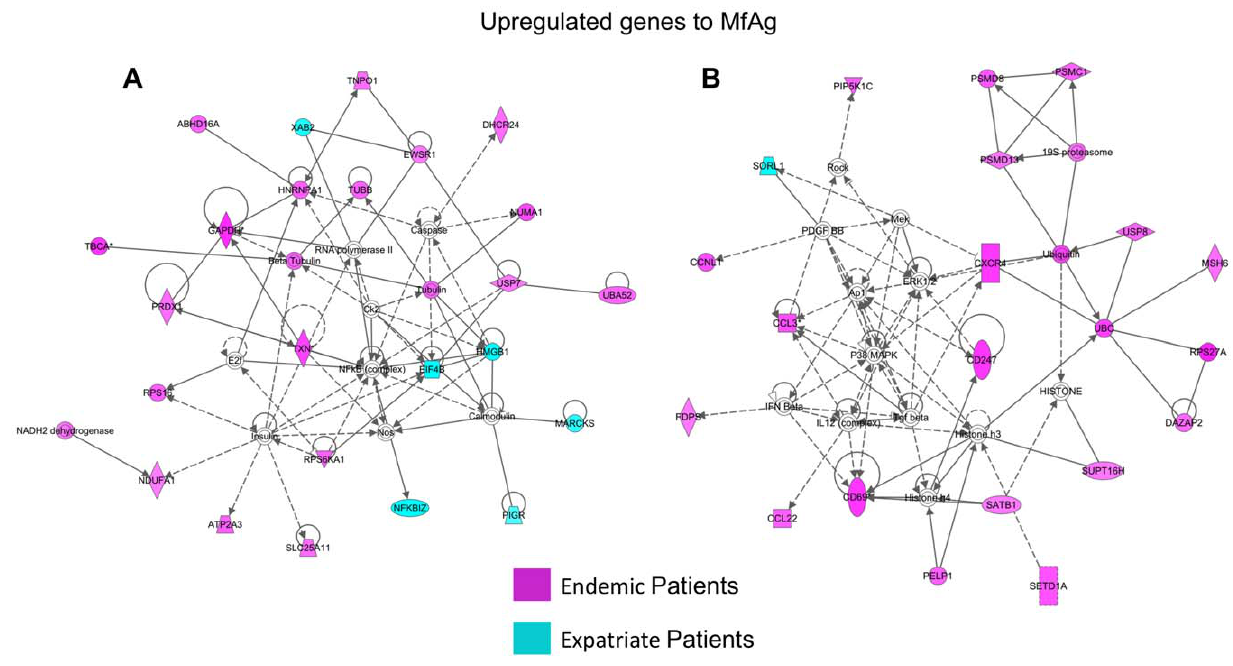
Figure 6. Networks of microfilarial Ag-driven upregulated genes. Two major networks (Figures A and B; www.ingenuity.com) of differentially expressed molecules from either CD4 + or CD8 + T cells that were significantly upregulated (p , 0.001) to MfAg in endemic (in red) and expatriate (in blue) patients. Lines represent direct (solid lines) and indirect (dashed lines) relationships between molecules, and molecules within double circles represent complexes of